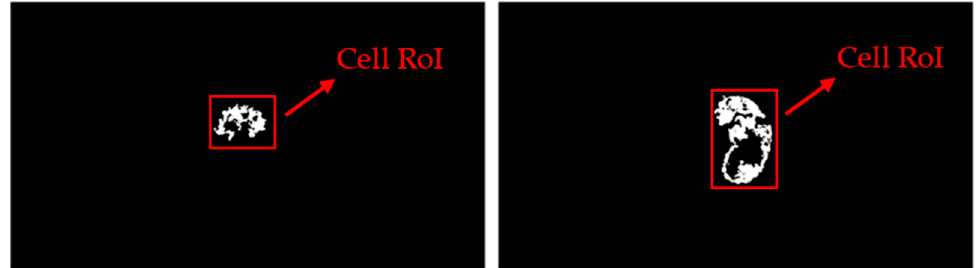
Figure 3. The results of cell recognition based on optical flow. cilia 1 (left), and cilia 2 (right).